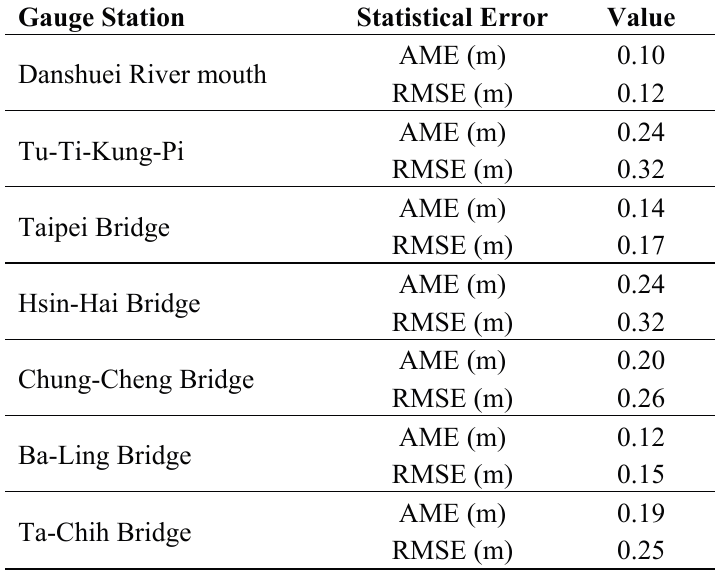
Table 1. Statistical error between simulated and measured water surface elevations at seven tidal stations during the period of 27 February to 8 March